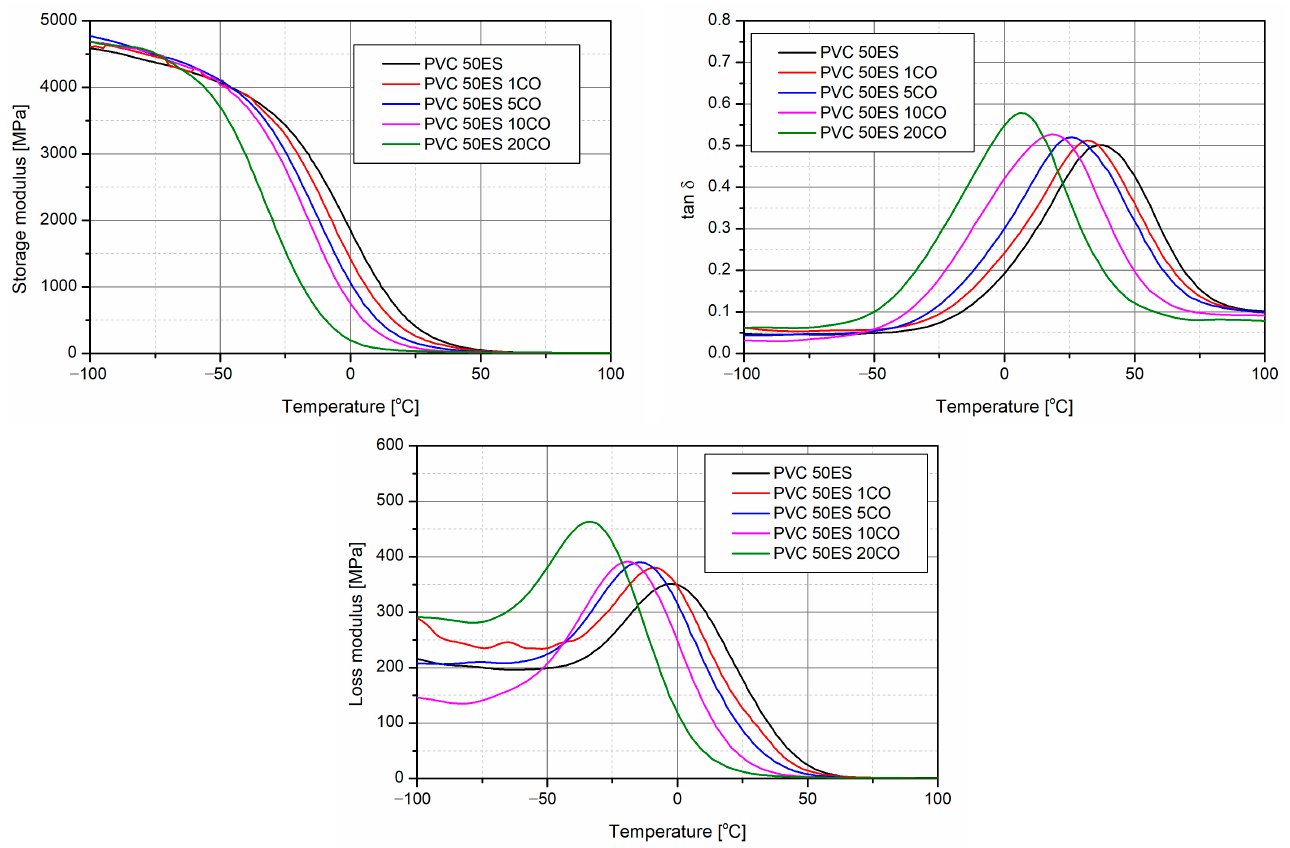
Figure 5. Thermograms of the DMA analysis of investigated materials. Table 2. Characteristic values of the DMA analysis.